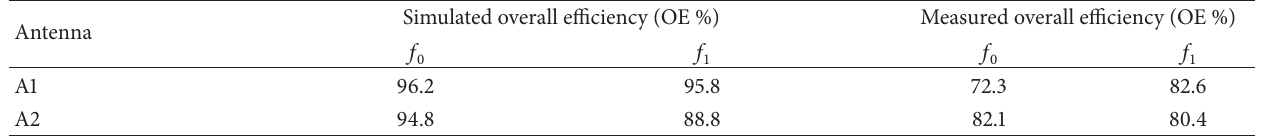
Table 2: Simulated and measured overall efficency (OE) for the two proposed antennas. Simulated overall efficiency (OE Antenna